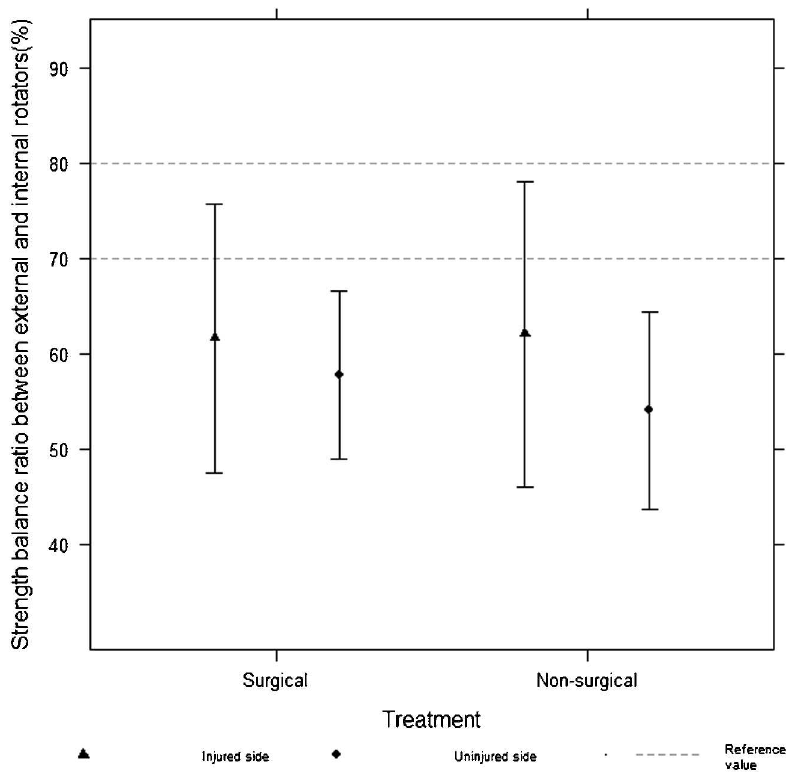
Figure 3 - Balance ratio between the external and internal rotator muscles of the shoulder for concentric action in athletes who underwent surgical and non-surgical